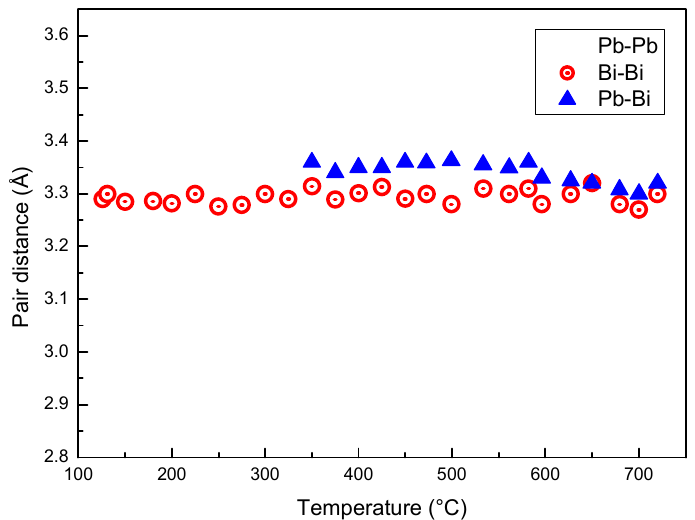
Figure 6. Distance between Pb–Pb, Bi–Bi and Pb–Bi pairs vs. temperature. From the fitting of the 1st and 2nd peaks of RDF curves the ratios r 2 /r 1 of Pb–Pb, Bi–Bi and Pb–Bi pairs vs. temperature have been determined (Figure 7). The ratios of Pb–Bi and Bi–Bi pairs slightly increase with temperature, whereas, that of Pb–Pb pairs exhibits a more pronounced variation from ~ 1,39 to ~ 1,62, two values very close to the ideal cubooctahedral and icosahedral configurations, respectively.